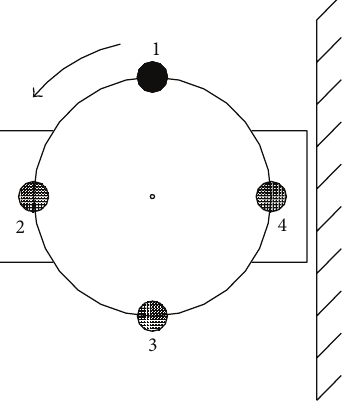
Figure 10: Unbalanced force